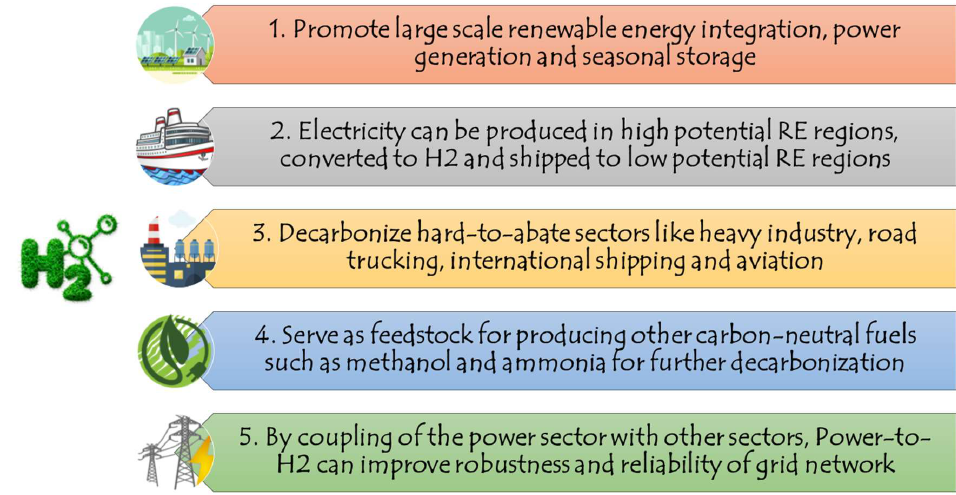
Figure 3. Role of green hydrogen in a carbon-neutral future.